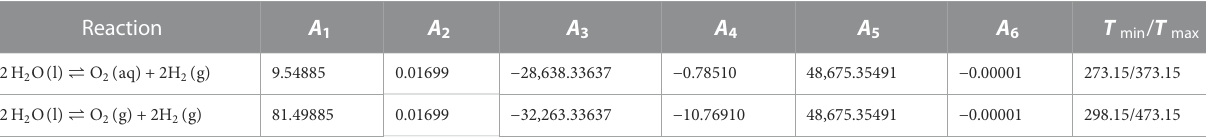
TABLE 6 Temperature parameters for log K (T) for E H reaction (Eqs 4, 5) according to Eq. 8.